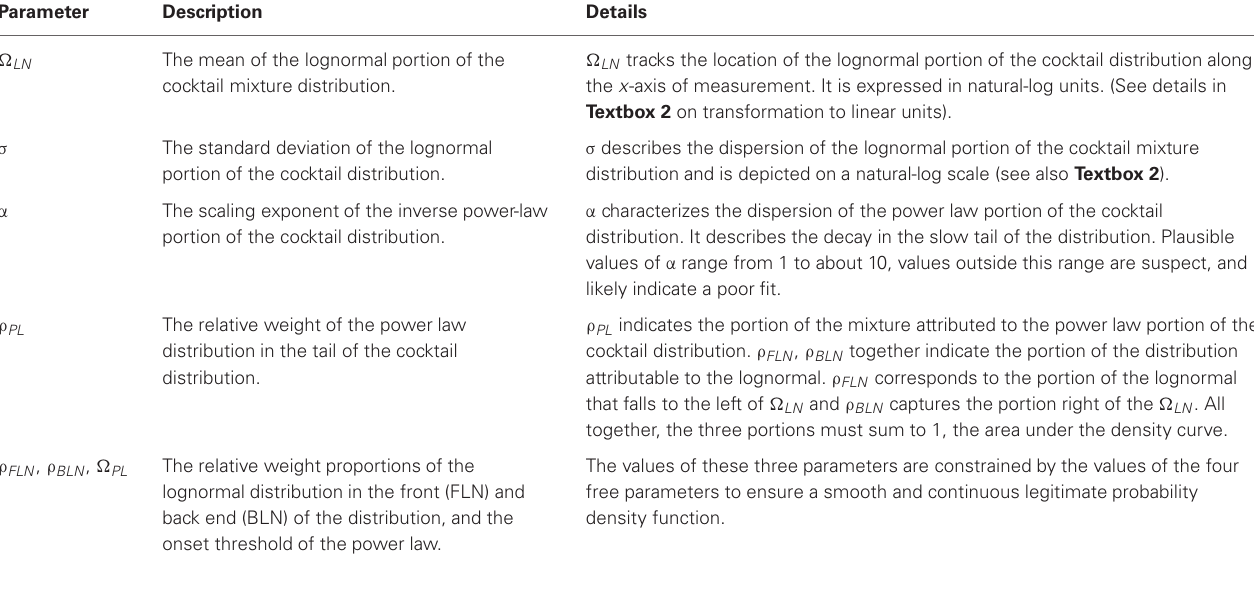
Table 1 | Parameters of the cocktail